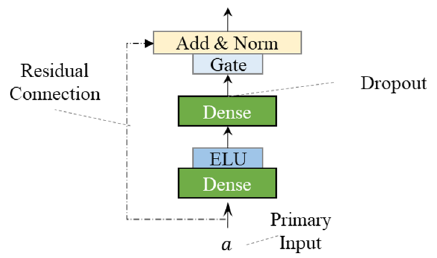
Figure 4. The structure of GRN.